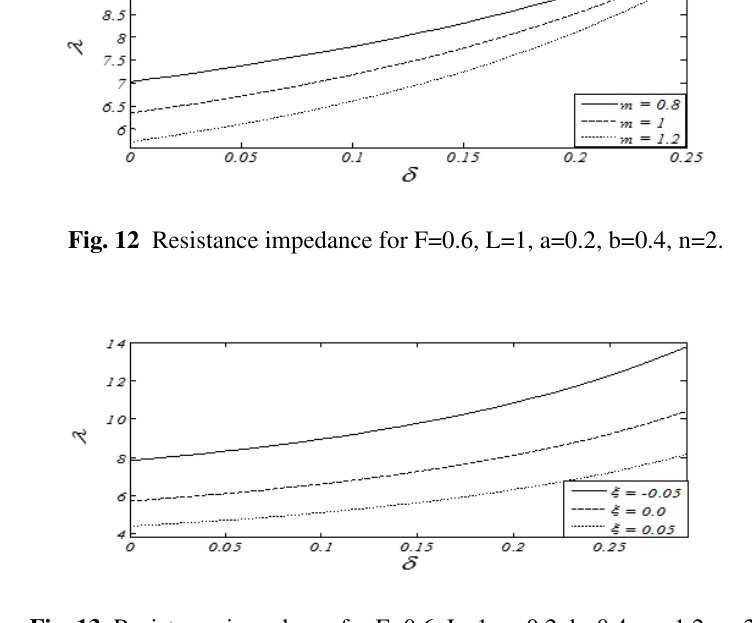
Fig. 13 Resistance impedance for F=0.6, L=1, a=0.2, b=0.4, m=1.2,